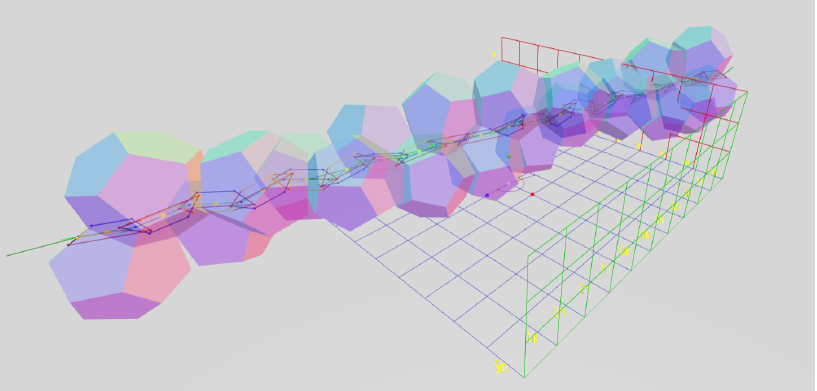
Figure 16. The Dodecadoubler.